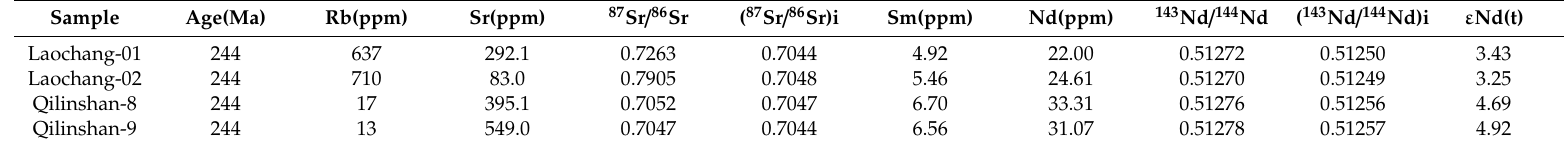
Table 2. Sr–Nd isotopic compositions of Qilinshan and Laochang basalts.